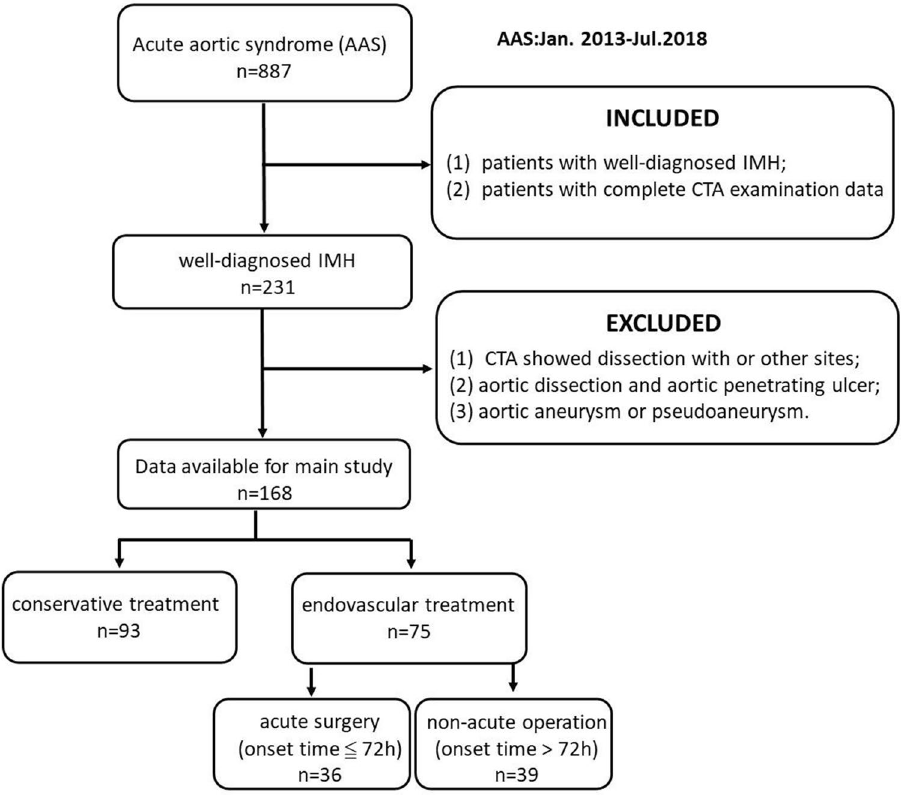
Figure 1. Flowchart of the study experimental object